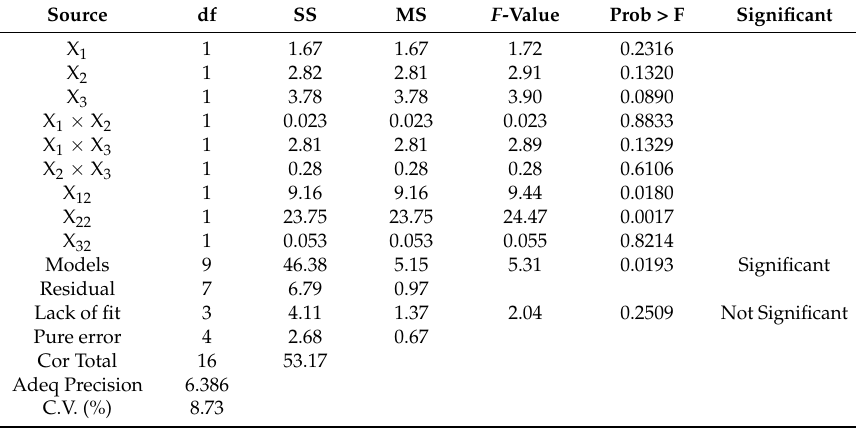
Table 2. Analysis of variance (ANOVA) of response surface quadratic model analysis for the ultrasonic